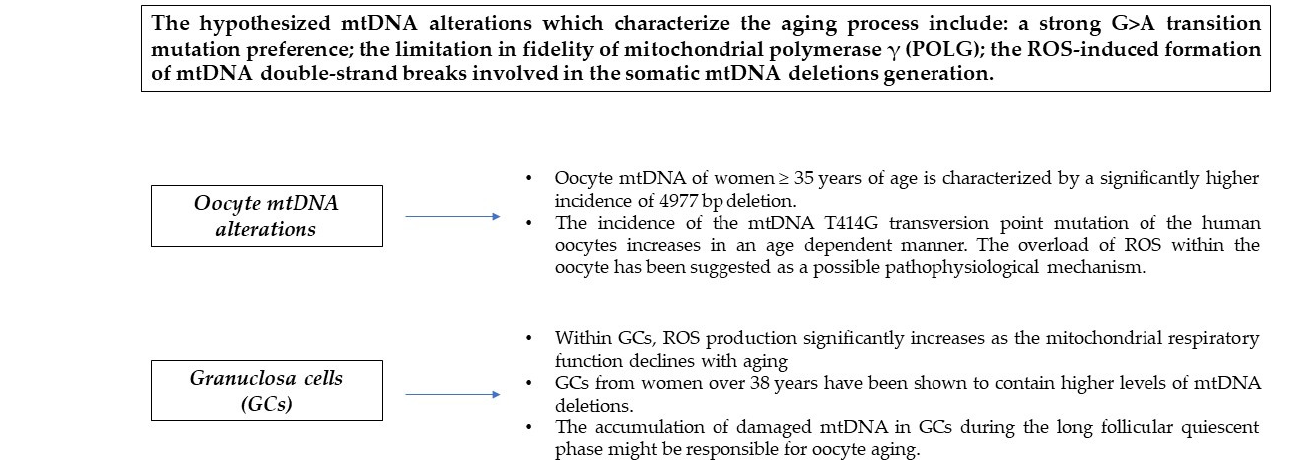
Figure 1. Qualitative mtDNA alterations and female fertility.